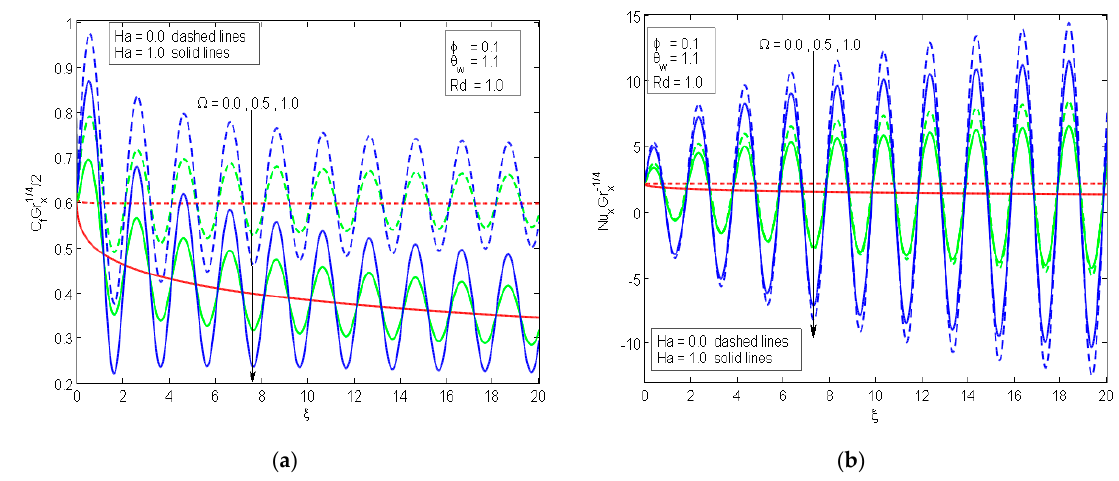
Figure 4. Effectiveness of Ha and Ω on drag coefficient ( a ) and Nusselt number ( b ). (cid:48) ( ξ Figure 5a,b elucidates the velocity f , η ) and temperature θ ( ξ , η ) curves with diverse values of radiation parameter Rd and nanoparticle volume fraction φ . It is clear that a greater value